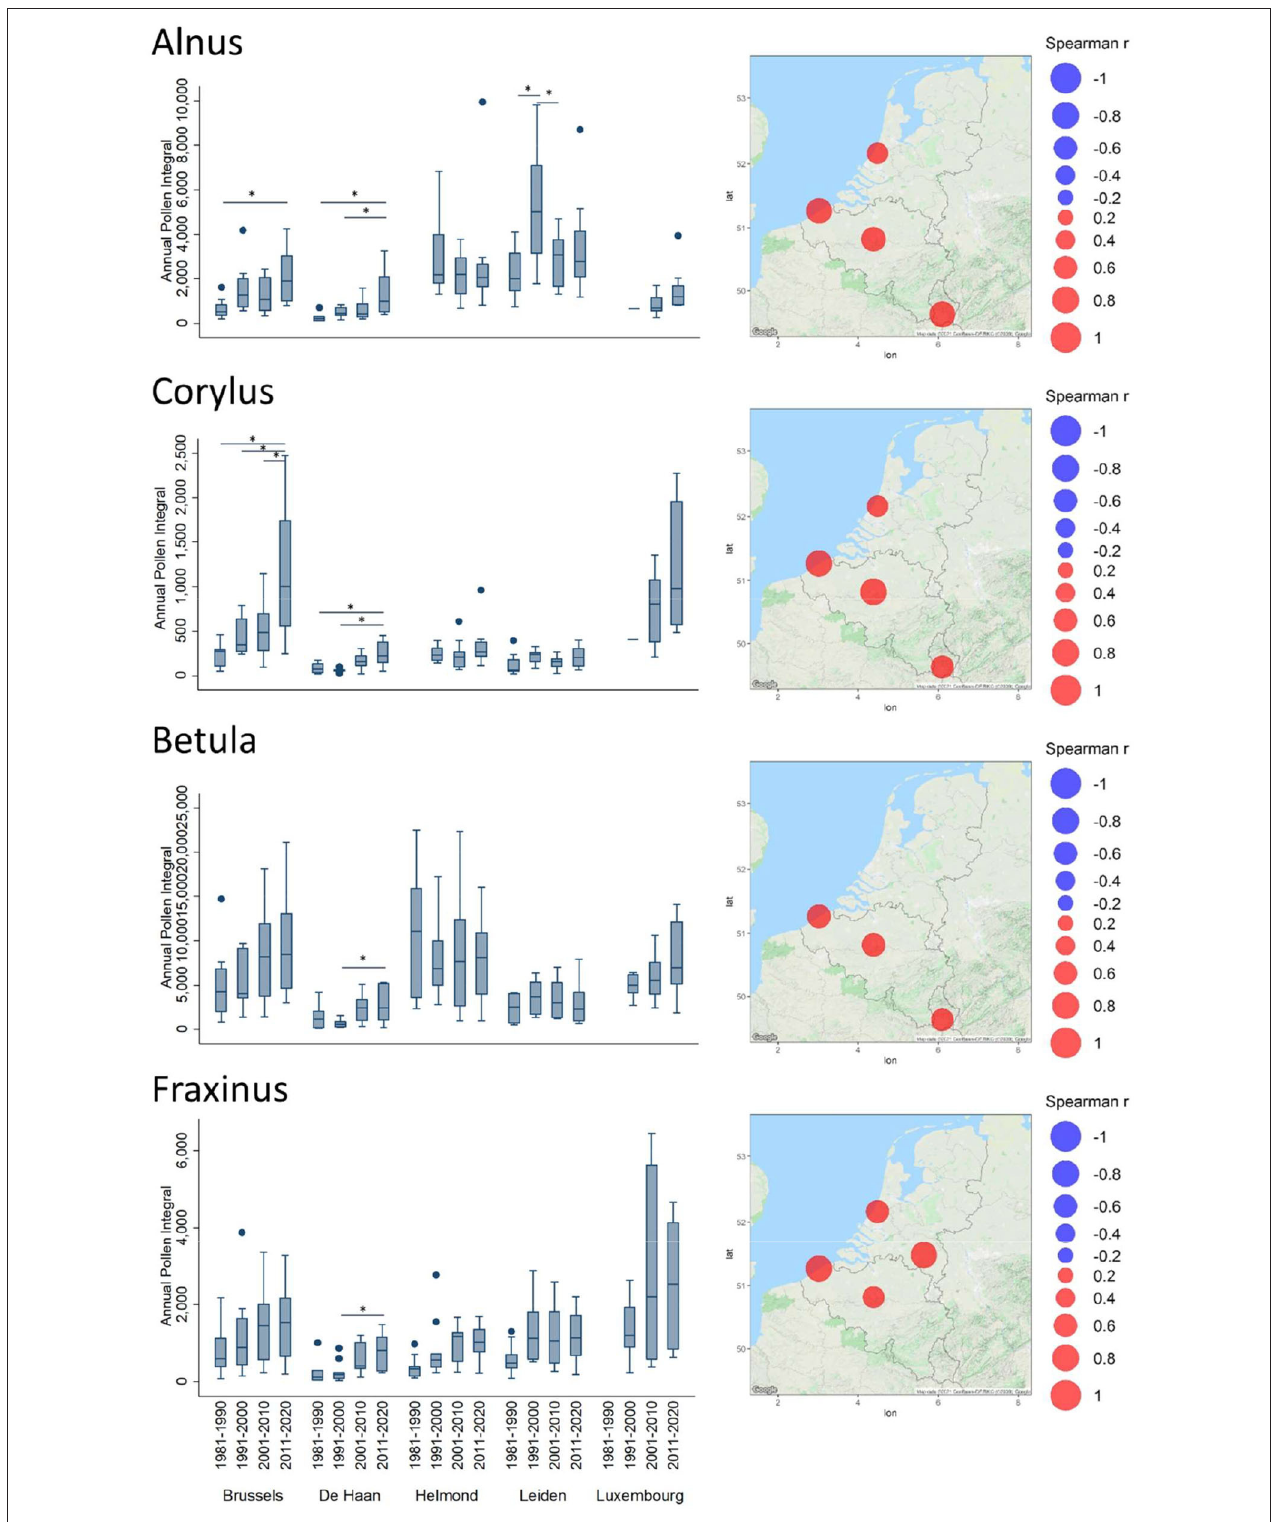
FIGURE 2 | Trends of Annual Pollen Integrals (API) for Alnus , Corylus , Betula , and Fraxinus . Spearman correlation coefficient (Rho) values between API and years are plotted in bubble maps at the location of the monitoring stations, from negative (in blue) to positive (in red). The bubble size relates to the magnitude of the Rho value.